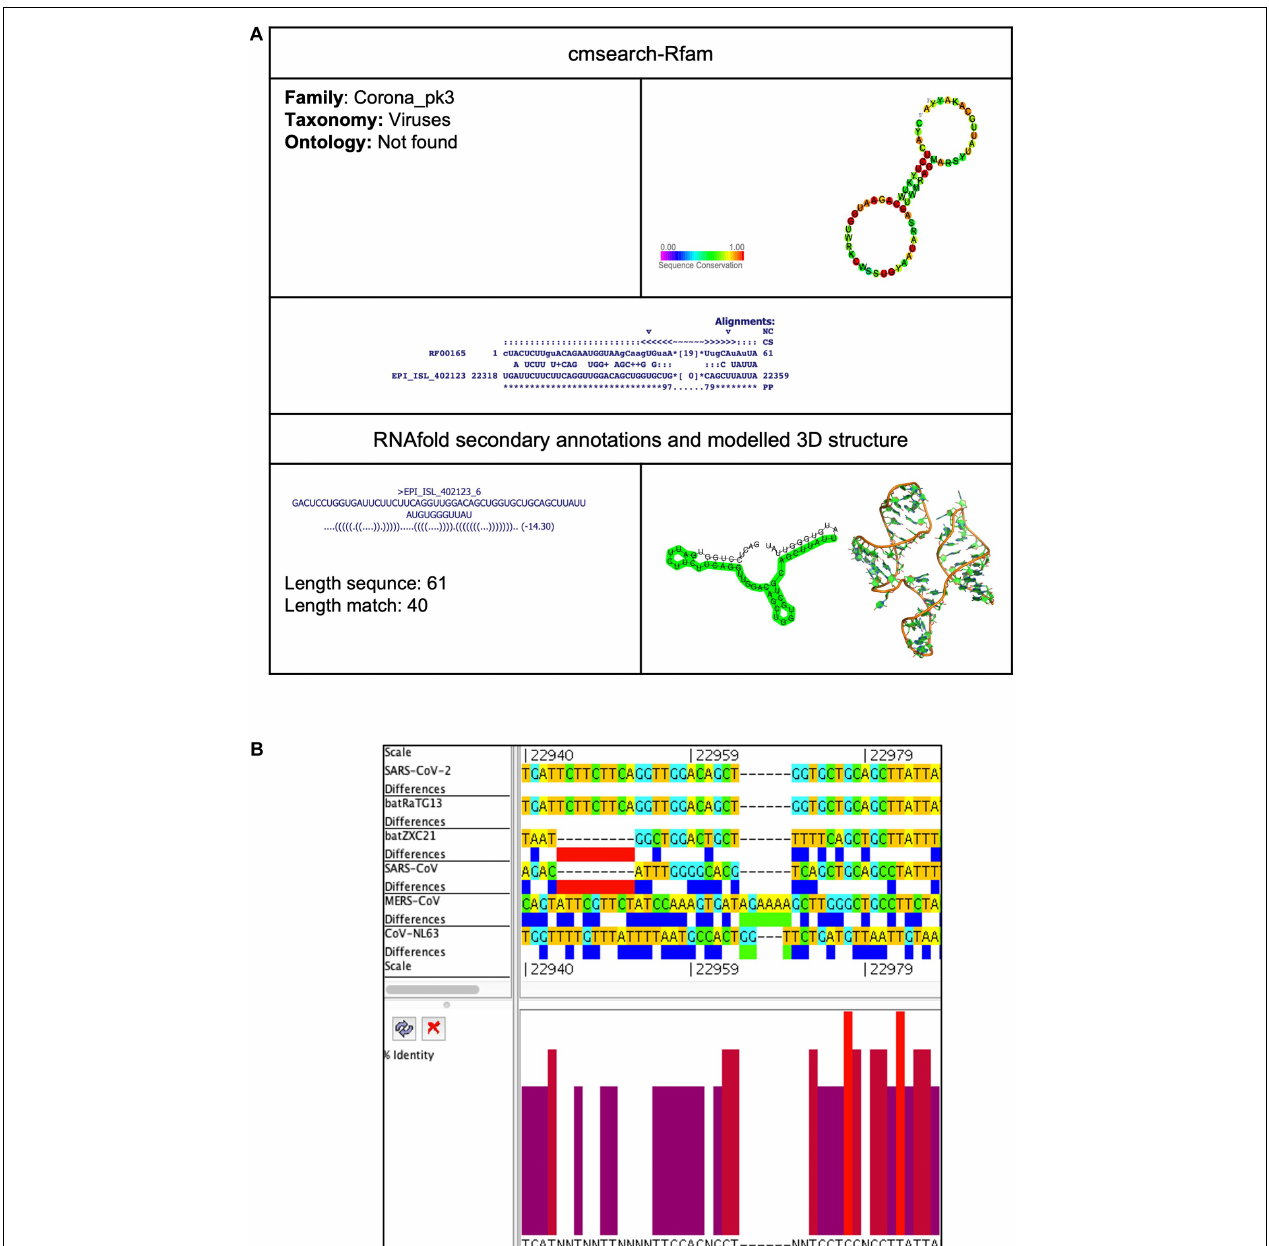
FIGURE 7 | Corona_pk3 cis -acting RNA element in the SARS-CoV-2 genome. (A) The sequence and RNA structure of Corona_pk3 is located in position 22,318–22,359 of the SARS-CoV-2 genome. In the 3-D structure, the phosphodiester backbone is shown in orange, and the nucleotides are shown in the sticks and filled rings with elemental coloring as C green, O red, and N blue. (B) Conservation of Corona_pk3 RNA sequence from various CoVs. The Corona_pk3 is located as aligned position 22,940–22,987. The navy blue box indicates mismatched nucleotides between the two sequences, and the red box indicates gaps between two sequences. Percentage identity in the histogram in which red indicates a perfect match and magenta indicates the low similarity of nucleotide.